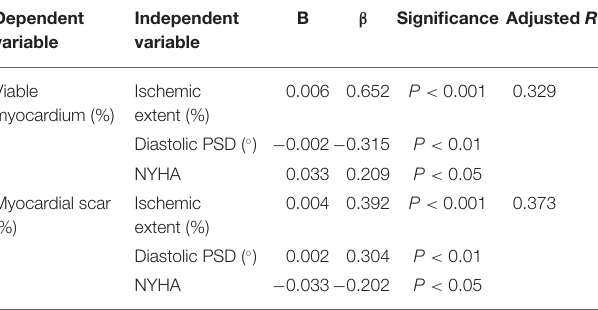
TABLE 3 | The multiple stepwise regression analysis for the prediction of the myocardial